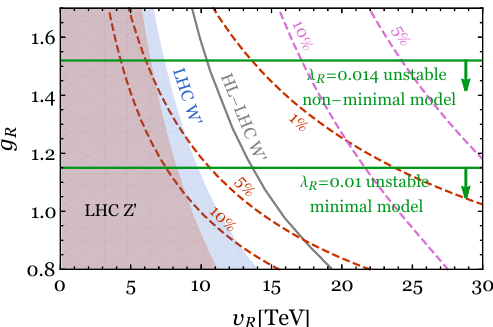
Figure 7 . The constraints on g R and v R at the LHC. The red and blue shaded regions are excluded by Z 0 and W 0 searches, respectively. The gray solid line denotes a prospective constraint from the W 0 search at the HL-LHC. Below the green solid lines, the potential of H R becomes unstable at an energy scale below 10 v R for the minimal and extended models. The red and magenta dashed lines show 10%, 5% and 1% fine-tuning in the SM Higgs mass-squared parameter against quantum corrections from the heavy gauge bosons, with the SM Higgs being a bi-doublet and an SU(2) L doublet,